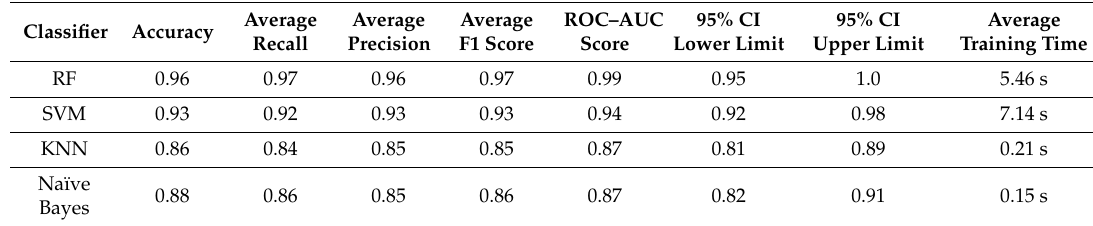
Table 7. Comparative analysis of multiple